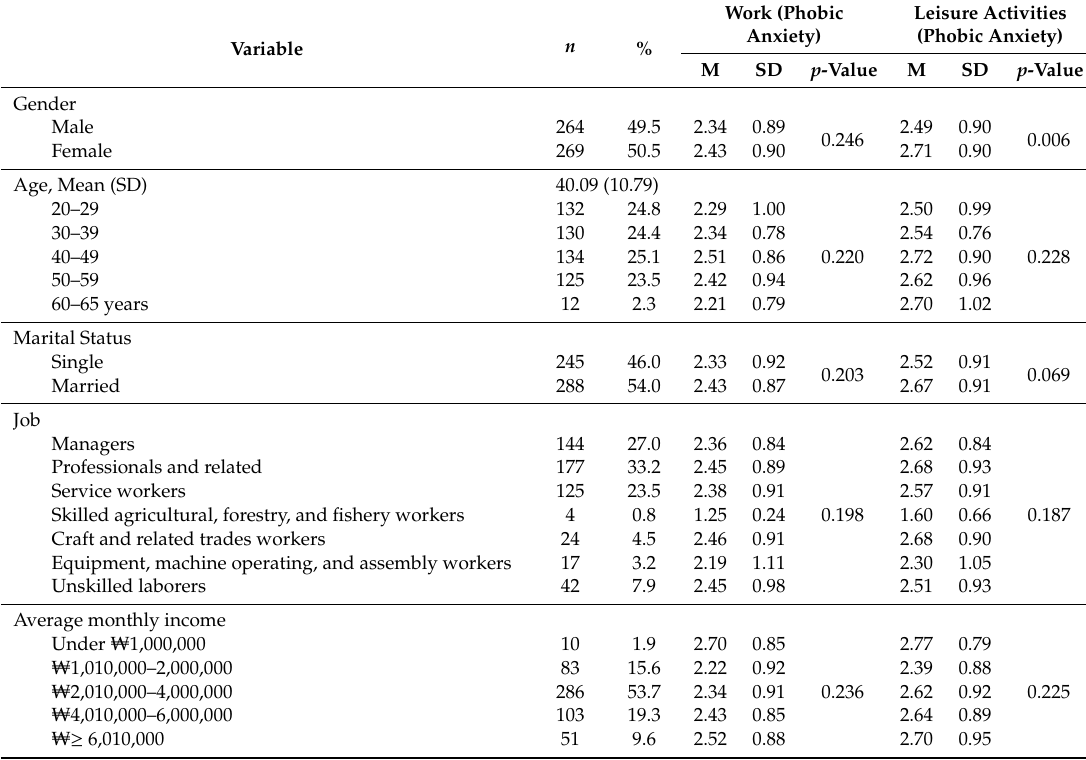
Table 1. Demographic characteristics ( n =